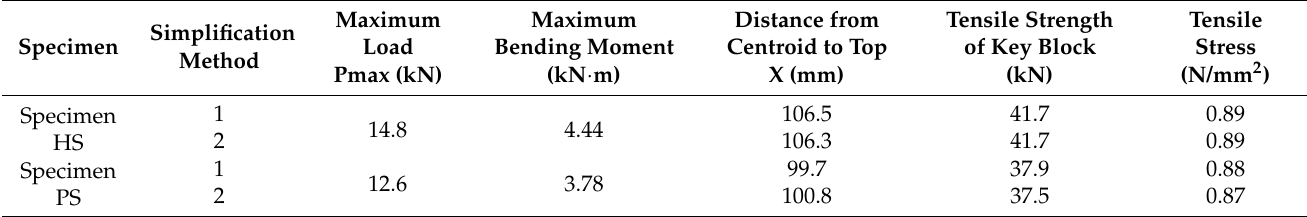
Table 7. Maximum load and tensile